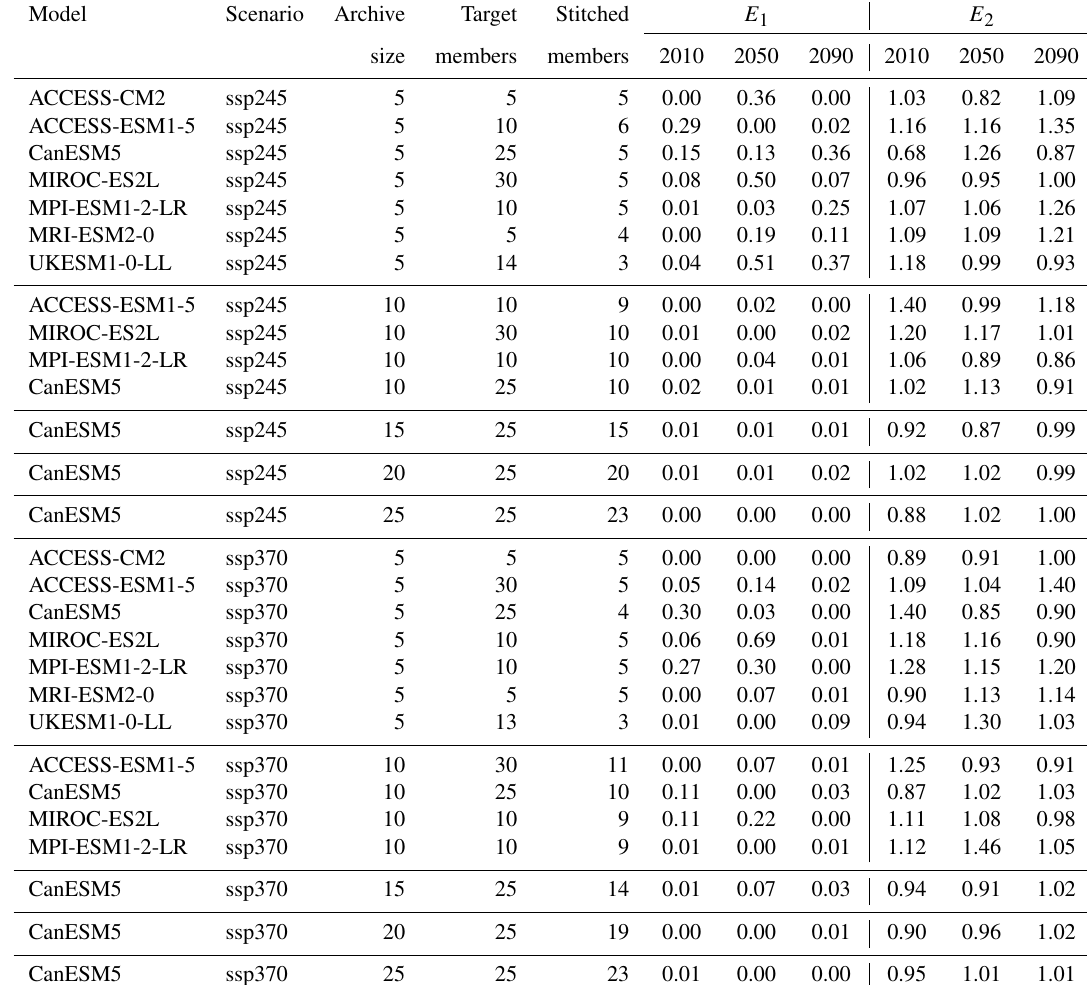
Table 4. The two components of the E r metric, E 1 and E 2 , computed for several experiments across ESMs, scenarios, and number of available archive trajectories from which to create the stitched ensembles. Numbers in columns 4 through 9 represent fractions of the target ensemble standard deviation (see Eq.